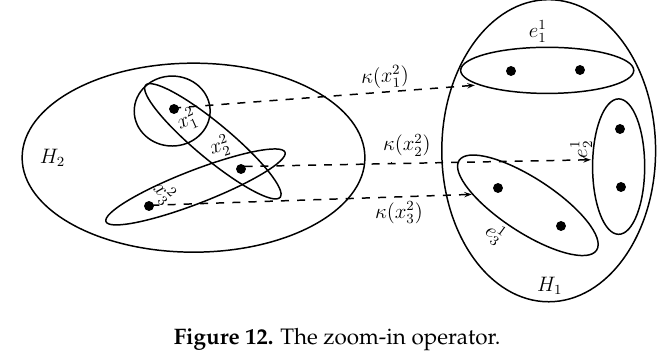
Figure 12. The zoom-in